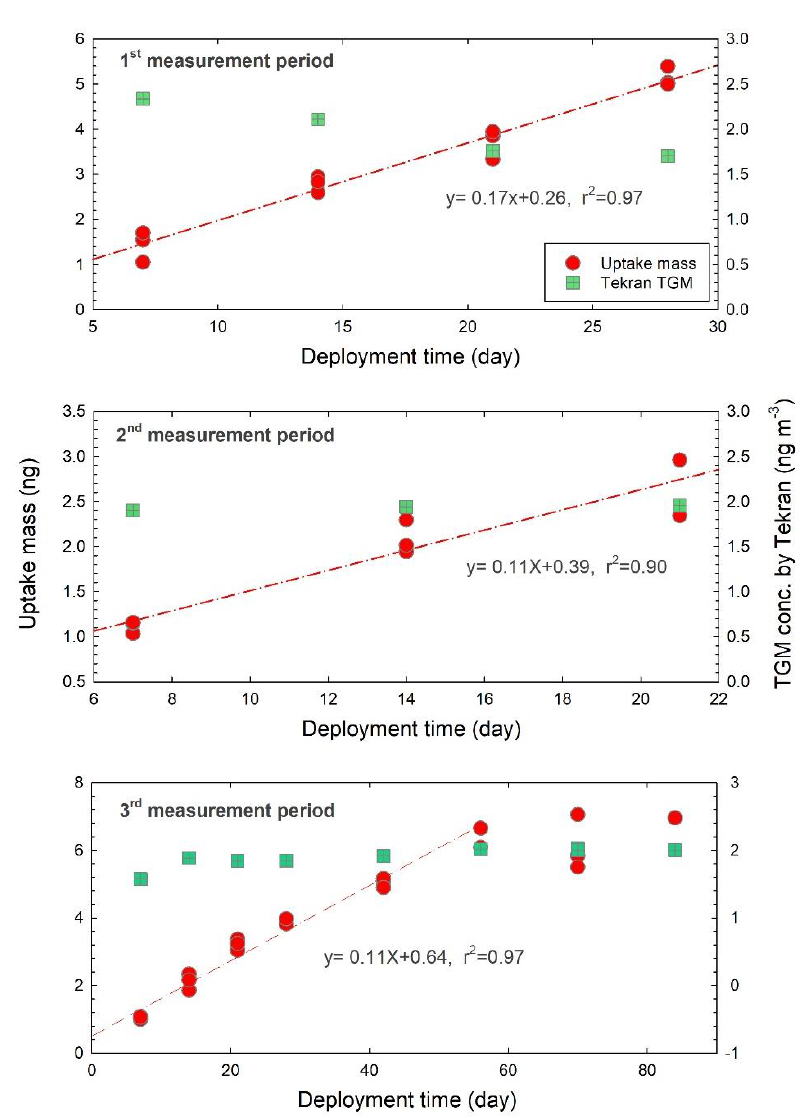
Figure 4. Increase in Hg uptake mass by the passive sampler with an increase in deployment time.